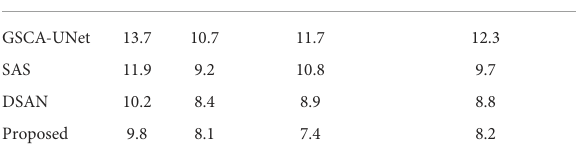
TABLE 1 The average detection results on the ISTD dataset. Method